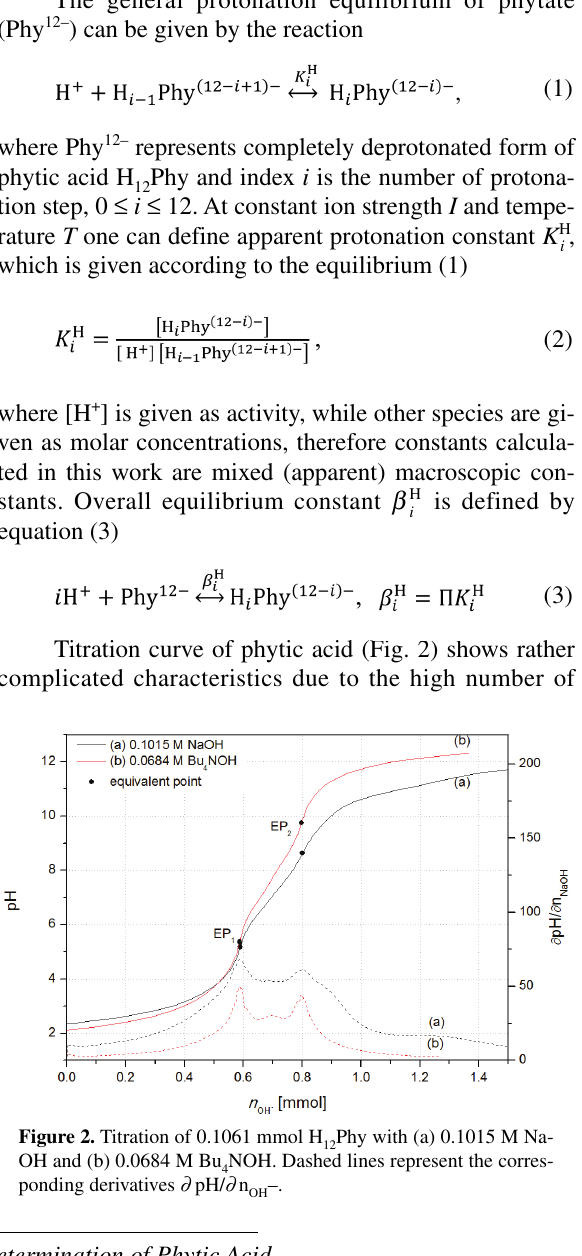
Phy with (a) 0.1015 M Na- 12 NOH. Dashed lines represent the corres- 4 OH